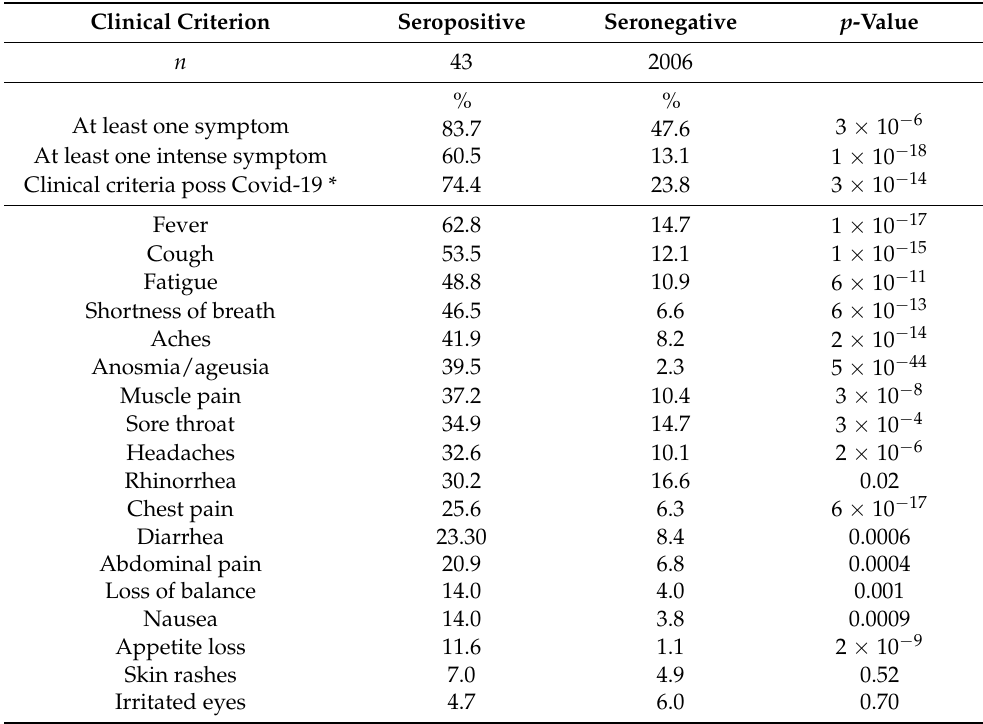
Table 3. Frequency of symptoms by serology